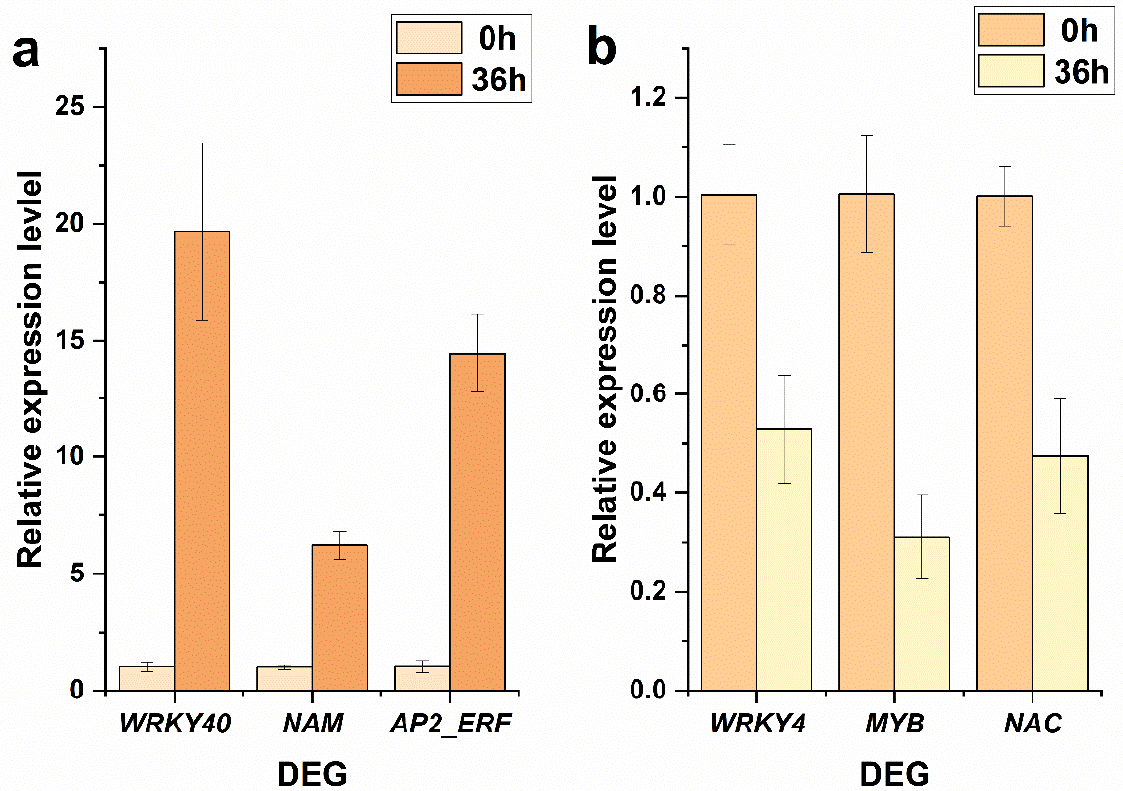
Figure 8. QRT-PCR verification on the expression change trends in several DEGs before and after salt stress. ( a ) QRT-PCR verification on the expression change trends of three up-regulated DEGs ( WRKY40 , Potri.001G044500; NAM , Potri.005G069500; AP2_ERF , Potri.018G038100). ( b ) QRT-PCR verification on the expression change trends of three down-regulated DEGs ( WRKY4 , Potri.008G091900; MYB , Potri.005G001600; NAC , Potri.007G135300).